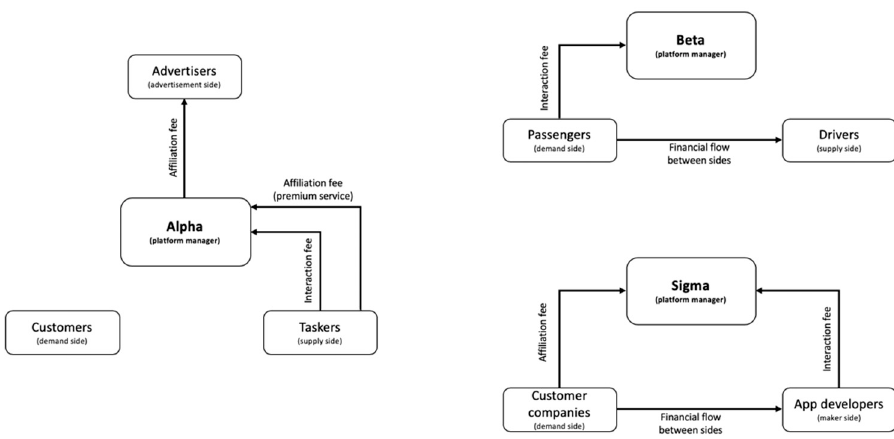
Figure 5. Revenue model in the three case studies.